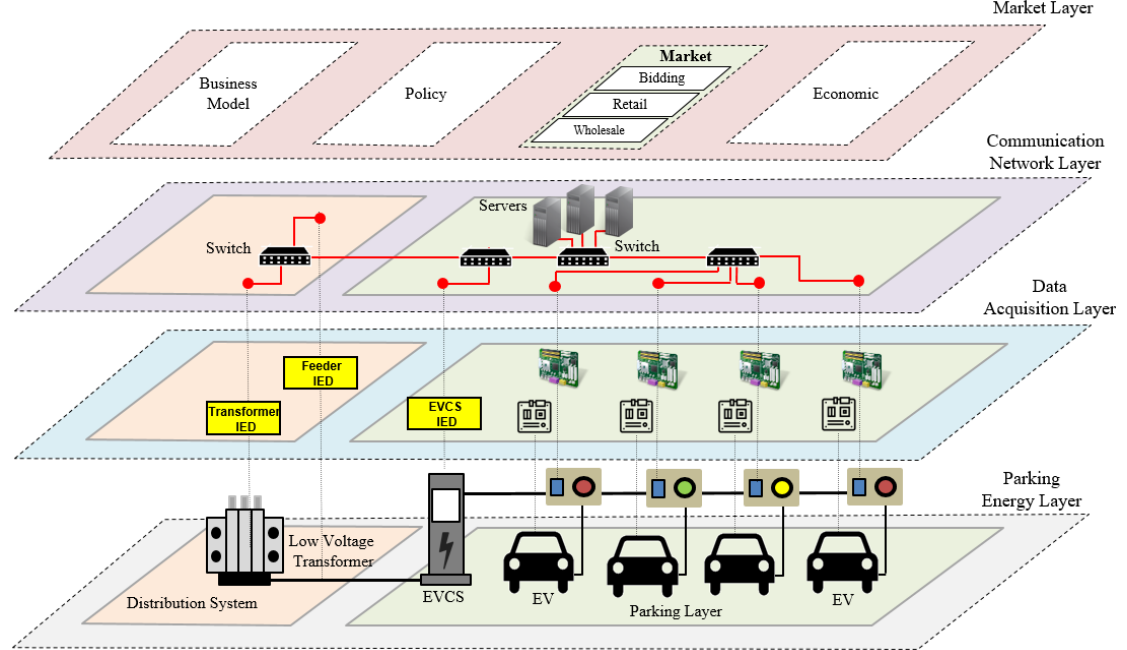
Figure 1. Proposed system architecture for energy trading in smart parking lots. EV: electric vehicle; EVCS: electric vehicle charging station; IED: intelligent electronic device.